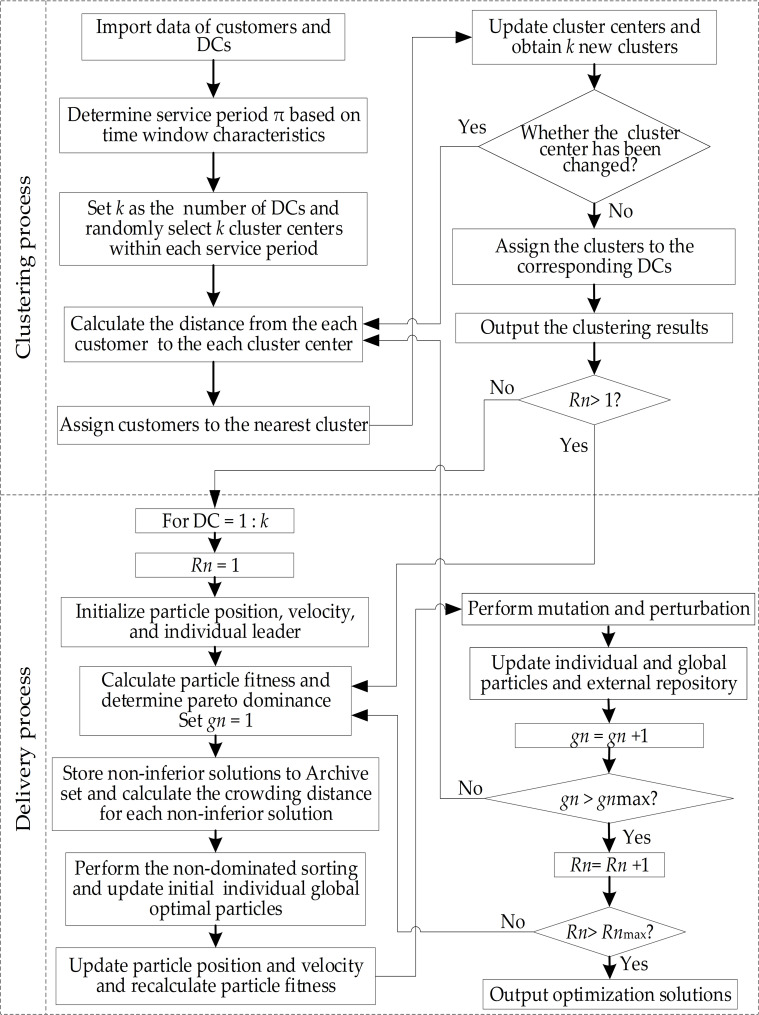
AGPSO flowchart.